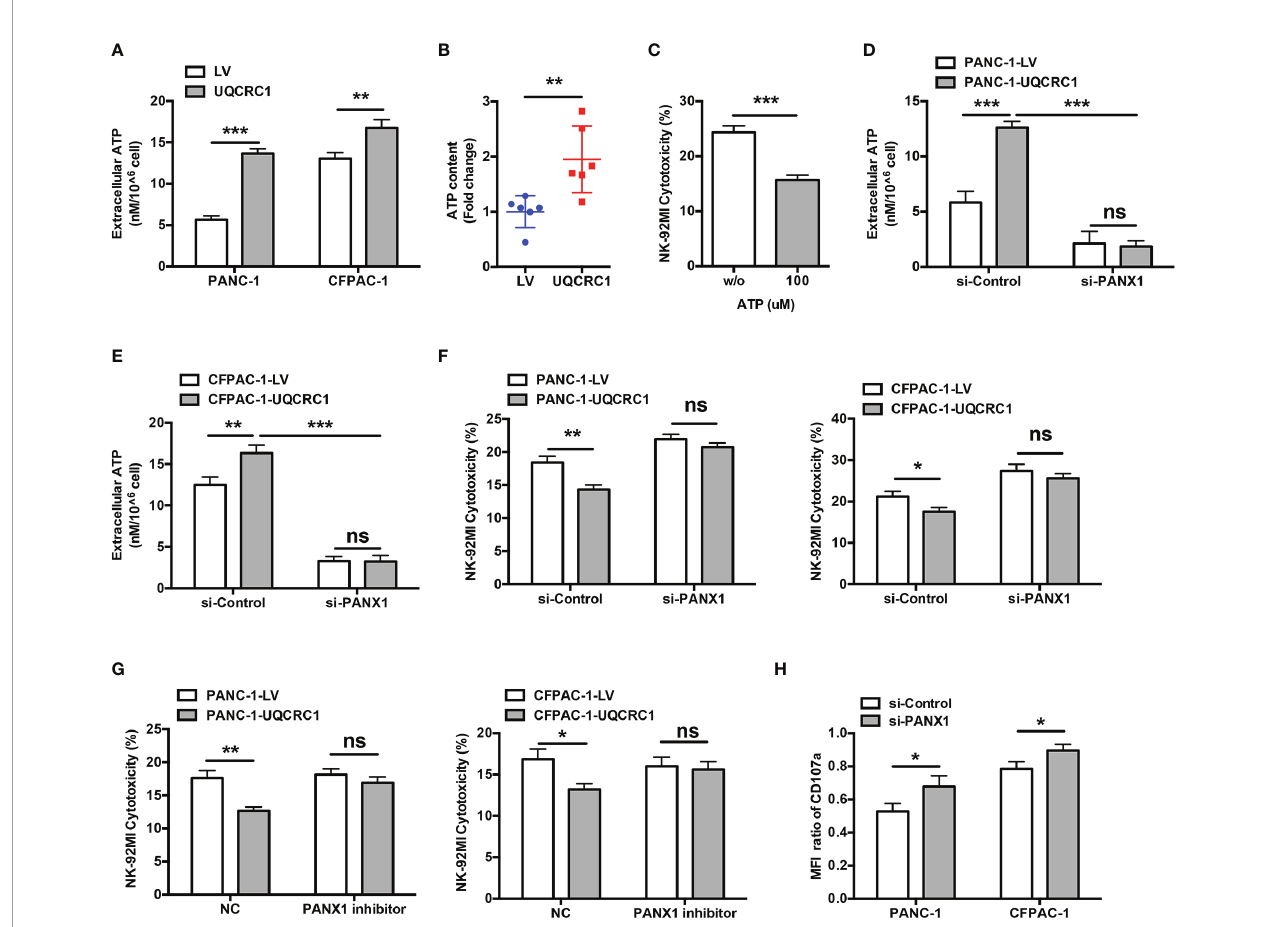
FIGURE 3 | Increased eATP mediates the UQCRC1-induced inhibition of NK cell cytotoxicity. (A) The eATP levels in the culture supernatant from UQCRC1- overexpressing and control PC cells. (B) The ATP content in UQCRC1-overexpressing and control subcutaneous xenografts. (C) The cytotoxicity of NK-92MI cells against parental PANC-1 cells in the presence of exogenous ATP. Before co-culture, the NK-92MI cells were pre-treated with 100 m M ATP for 3 h. (D) The eATP levels of UQCRC1-overexpressing and control PANC-1 or (E) CFPAC-1 cells after PANX1 knockdown. (F) The cytotoxic activity of NK-92MI cells against si-PANX1- treated UQCRC1-overexpressing or control PC (PANC-1 or CFPAC-1) cells. (G) The cytotoxicity of NK-92MI cells against UQCRC1-overexpressing or control PC cells (PANC-1 or CFPAC-1) in the presence of PANX1 inhibitor. Before co-culture, the PC cells were pre-treated with 100 m M 10Panx for 24h. (H) The expression changes of CD107a in NK-92MI cells after co-culture with si-PANX1-treated UQCRC1-overexpressing or control PC cells. The MFI ratio of CD107a was calculated as the MFI of CD107a in NK cells incubated with UQCRC1-overexpressing tumor cells divided by the MFI of CD107a in NK cells incubated with control cells. All data are presented as the mean ± SD (n = 3 independent biological replicates). *, p < 0.05; **, p < 0.01; ***, p < 0.001; ns, not signi fi